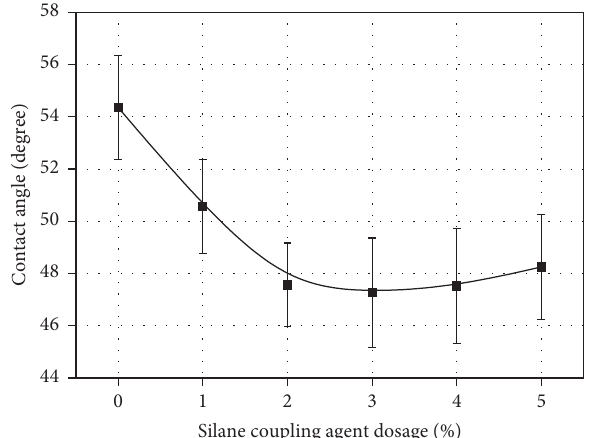
Figure 8: The asphaltene dosage of asphalt at different layers.